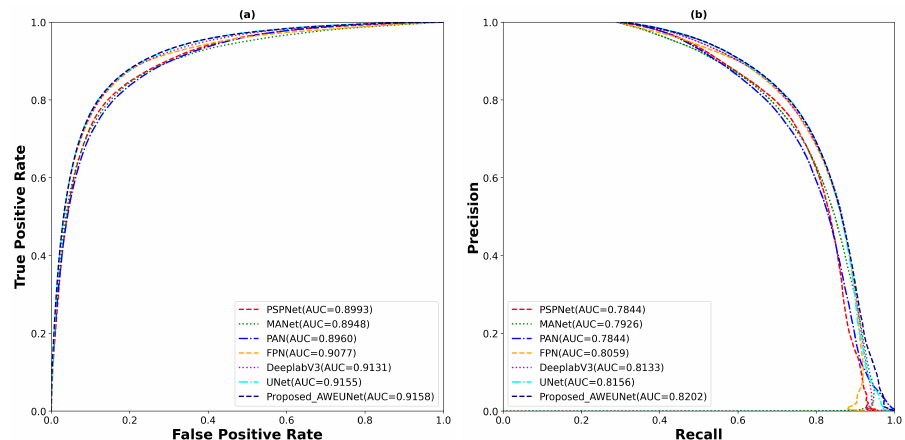
Figure 10. The ( a ) ROC and ( b ) PR curve for for all test samples of the LIDC-IDRI lung nodule segmentation